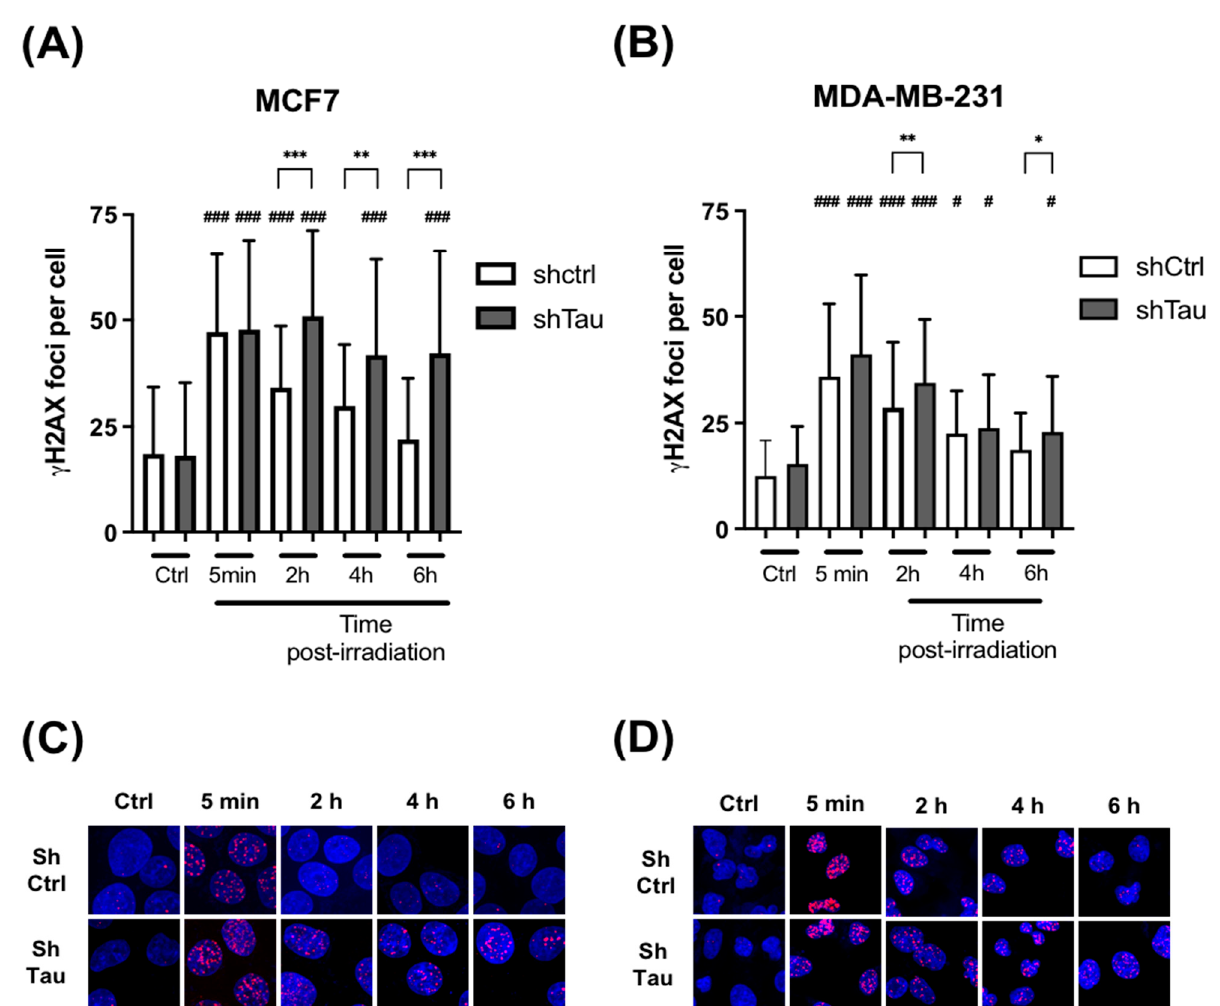
Figure 2. Inhibition of Tau increases γ -H2AX levels after X-ray treatment in MCF7 and MDA-MB-231. ( A ) MCF7 and ( B ) MDA-MB-231 shCtrl or shTau stable clones were X-irradiated with 2 Gy and then further incubated for 5 min, 2, 4, and 6 h. Cells were then labeled with a γ -H2AX antibody to quantify DNA double-strand breaks, and the number of γ -H2AX foci per cell was determined using Image J. All experiments were carried out in three independent experiments. Data are mean ± SD (n > 60 cells per conditions) * p < 0.05; ** p < 0.01; *** p < 0.001. # p < 0.05; ### p < 0.001 compared to untreated shCtrl cells. Representative images of γ -H2AX (red) staining in ( C ) MCF7 and ( D ) MDA-MB-231 shCtrl or shTau stable clones irradiated or not with 2 Gy. DAPI nuclear counterstaining is shown in blue.